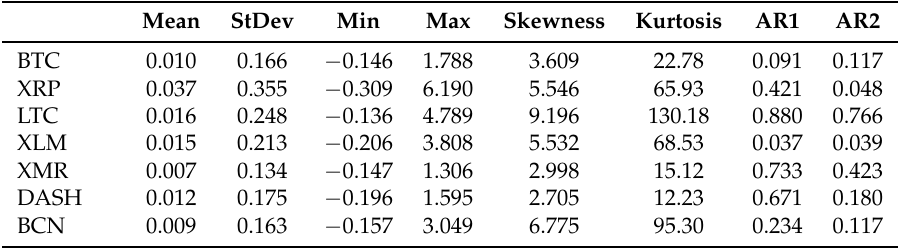
Table 1. Descriptive statistics of daily log-returns of